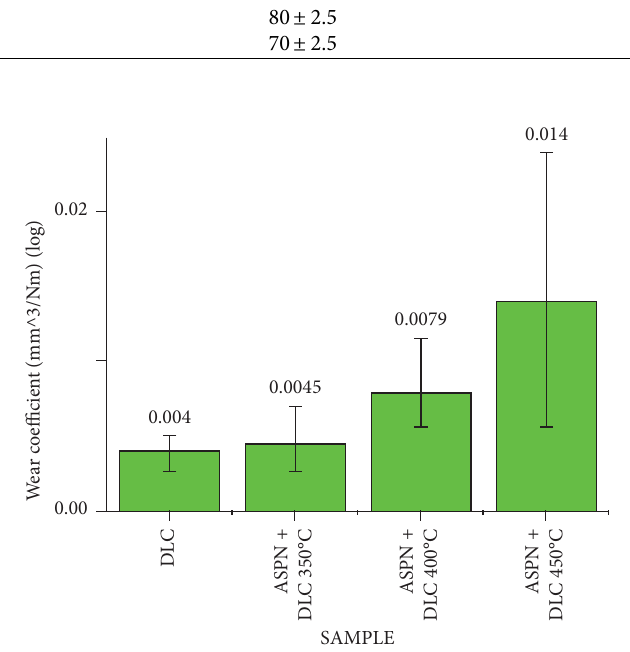
Figure 10: Wear coefcient (mm − 3 Nm − 1 ) of DLC coating reference and ASPN+ DLC